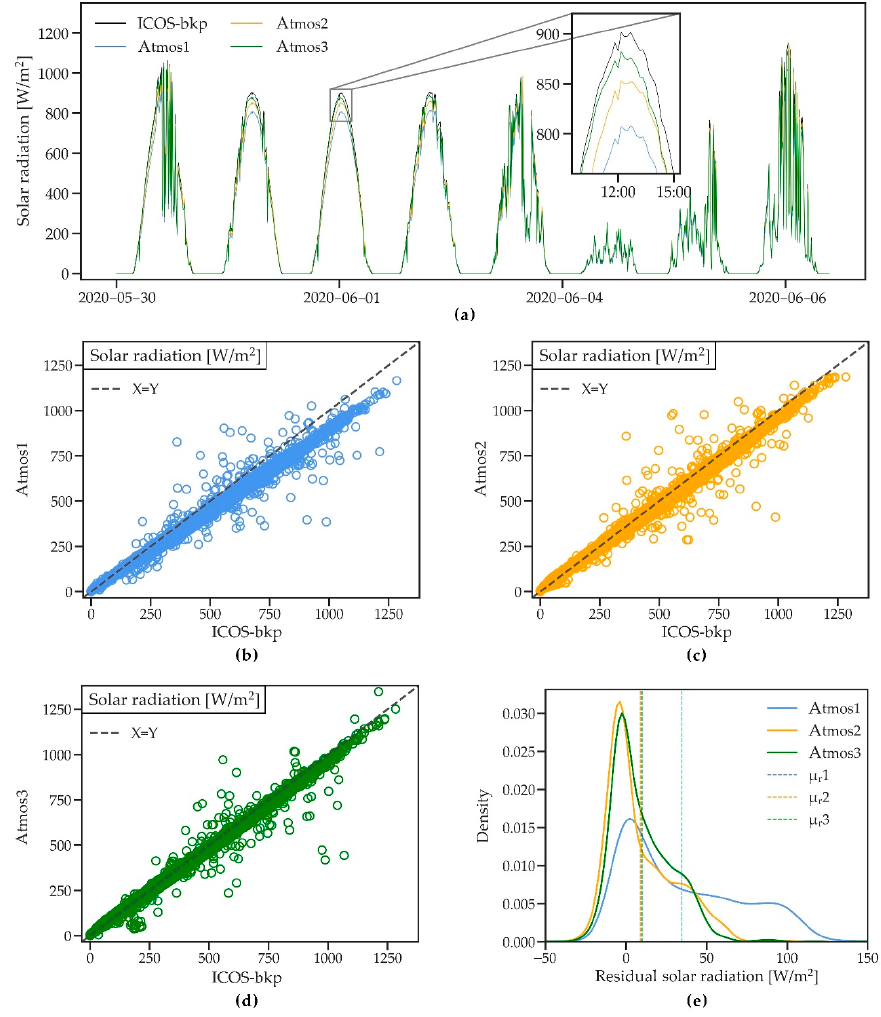
Figure 4. ( a ) A short time series of solar radiation measured by three ATMOS41 weather stations and the ICOS-bkp station from 30 May to 6 June 2020. ( b – d ) Scatterplots of 10 min solar radiation for the three ATMOS41 stations vs. the reference station. ( e ) Probability density functions of the residual mean hourly solar radiation. Dashed lines show the mean of residuals ( μ r ). The scatterplots of the ATMOS41 station vs. the ICOS-bkp (Figure 4b–d) confirm the overall good agreement of the stations, with an R 2 between 0.96 and 0.99 (Table 4). The plots show little scatter and RMSE is ~32 W/m 2 for Atmos2 and Atmos3 and somewhat